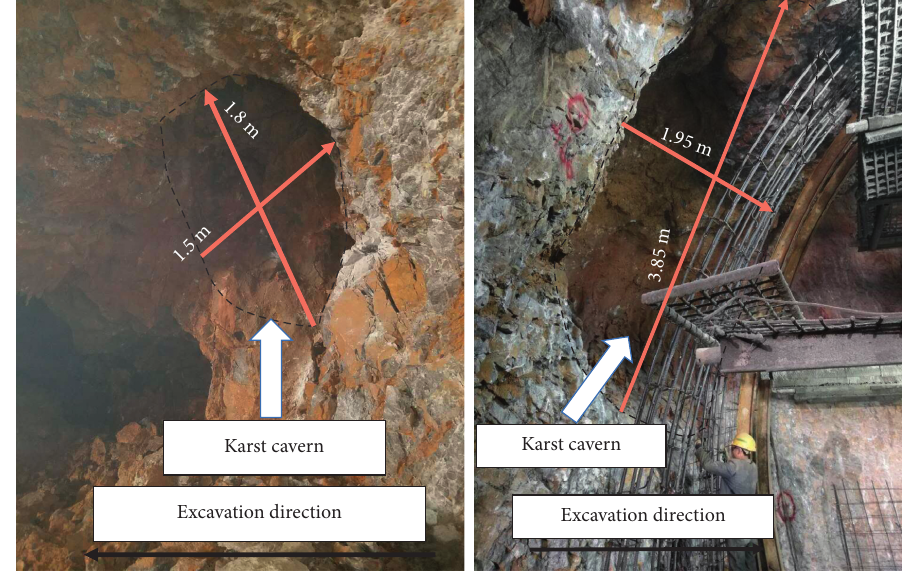
Figure 3: Cave at arch waist of the Hebai